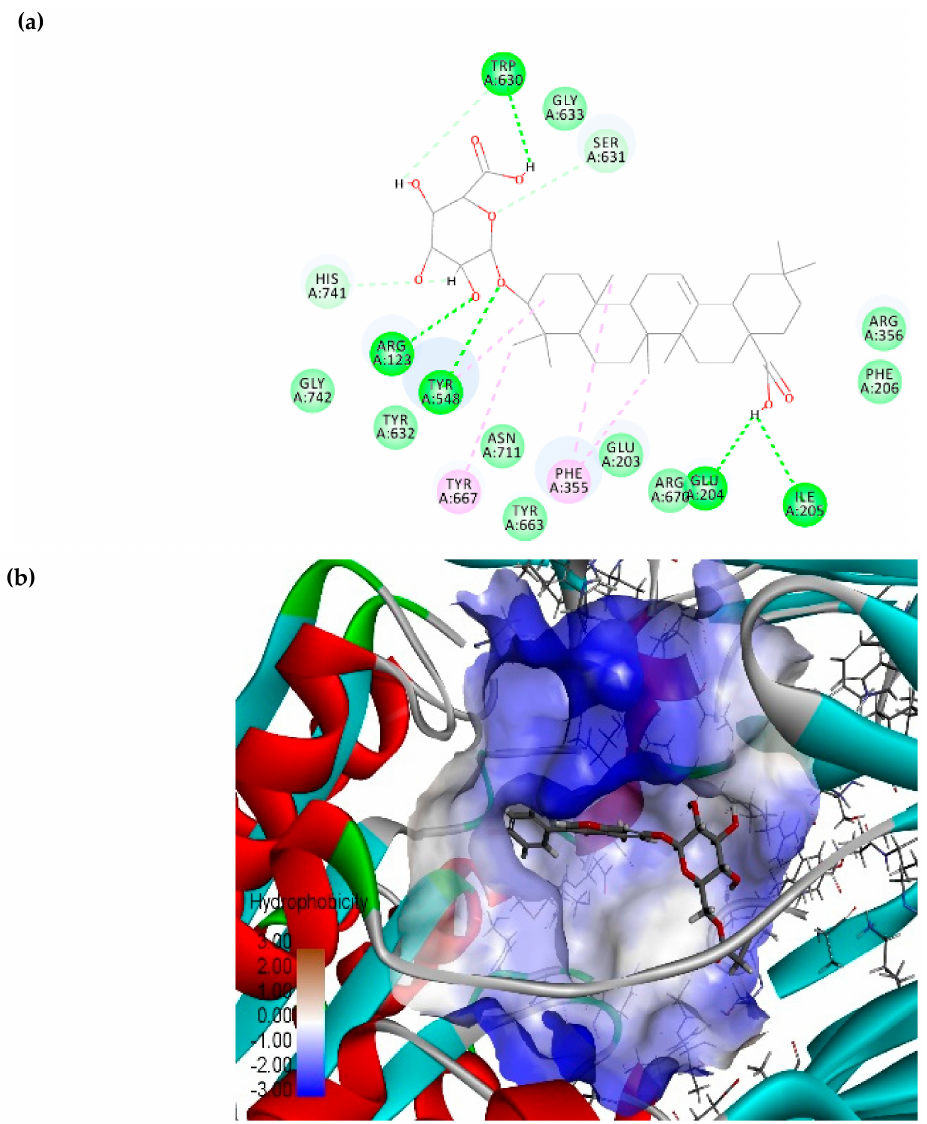
Figure 9. Phytochemical malonylgenistein bound structure on DPP-4 druggable region with active site residue interacting analysis. ( a ) Two-dimensional interaction analysis, ( b ) binding pose